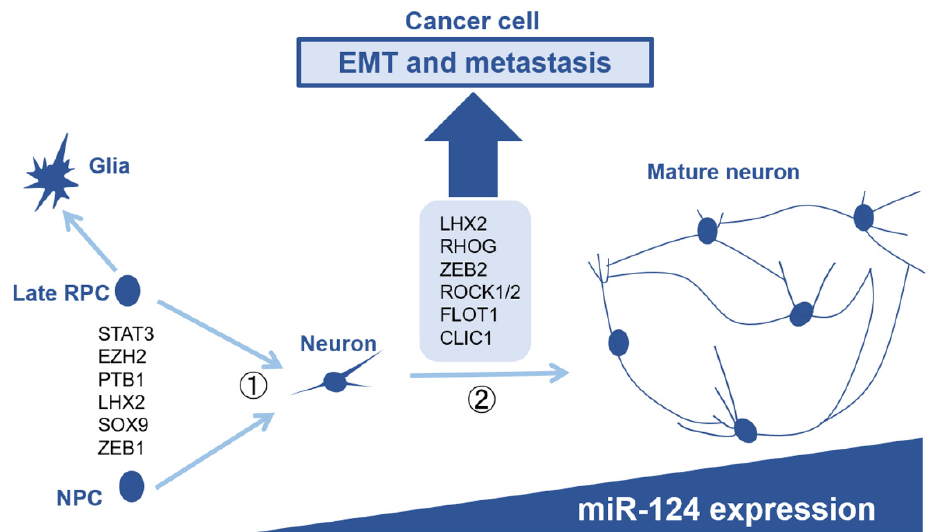
Figure 3. The role of microRNA-124 in neurogenesis and its tumor suppressive effect. miR-124 is strongly expressed in neurons, and its expression increases as the neurons mature. miR-124 is thought to act as a gatekeeper during the generation of neurons from non-neuronal cells, thus preventing the reversal of cell fate. In the process of neuronal maturation, miR-124 targets genes that contribute to proper neuronal migration, neurite formation, and synapse formation. Genes that contribute to neuronal maturation also contribute to EMT and metastasis in cancer cells. Abbreviations: RPC, retinal progenitor cell; NPC, neural progenitor cell; EMT, epithelial-mesenchymal transition. During brain development, neurons are derived from neural progenitor cells called radial glia. In contrast, in the retina, both neurons and glial cells are produced from common retinal progenitor cells. STAT3 is an important target gene of miR-124 for its tumor suppressor effect, while in nervous system development, it is known to contribute to astrocyte differentiation [119]. In addition, P19 cells, an embryonic-derived teratoma cell line, can also differentiate into neurons and astrocytes. miR-124 reportedly targets EZH2 to allow differentiation of P19 cells into neurons and suppresses their differentiation into astrocytes [120]. Therefore, miR-124 is also thought to play a role in suppressing glial cell differentiation. Overexpression of miR-124 in mouse retinal progenitor cells decreases the percentage of glial cell differentiation and increases the percentage of neuronal differentiation [121]. Thus, it is possible that STAT3 and EZH2 are also targeted in the active fate determination of neurons from retinal progenitor cells in actual in vivo